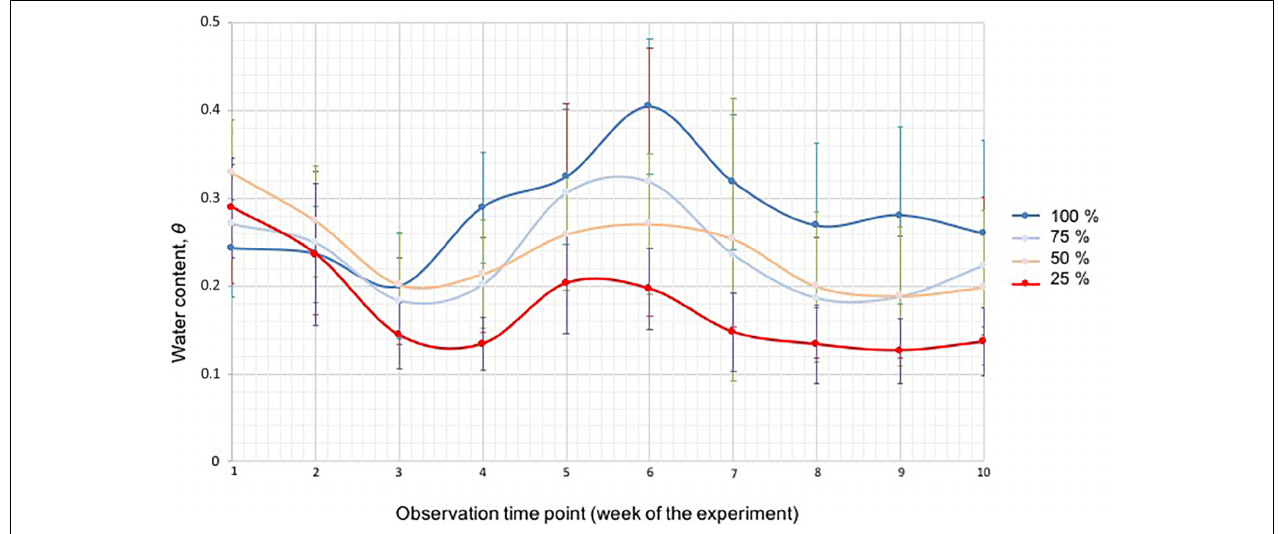
FIGURE 5 | The soil moisture of the four different water treatment groups (100% blue, 75% light blue, 50% green, and 25% red) measured with a soil moisture meter, shown as water content (cid:9) for each week during the duration of the experiment. The bars represent standard